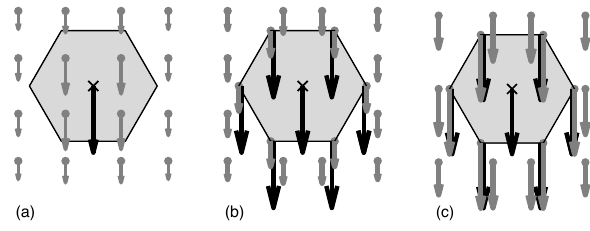
Figure 1. Velocity field of the fluid (grey arrows) around a sink- ing particle for macroscopic simulation (a), immersed boundary conditions (b) with flow velocity on the particle surface deviating from the particle velocity and microscopic simulation (c) with the particle velocity acting as boundary condition for the